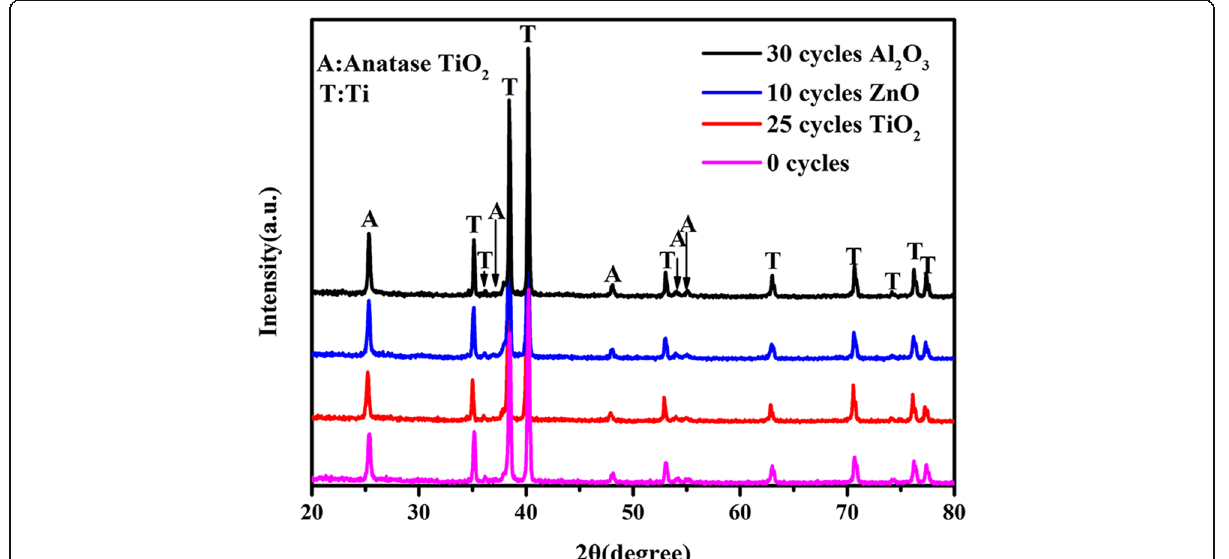
Fig. 3 XRD patterns of the TNTAs/QDs, TNTAs/QDs/10 cycles ZnO, TNTAs/QDs/25 cycles TiO 2 , and TNTAs/QDs/30 cycles Al 2 O 3 electrodes